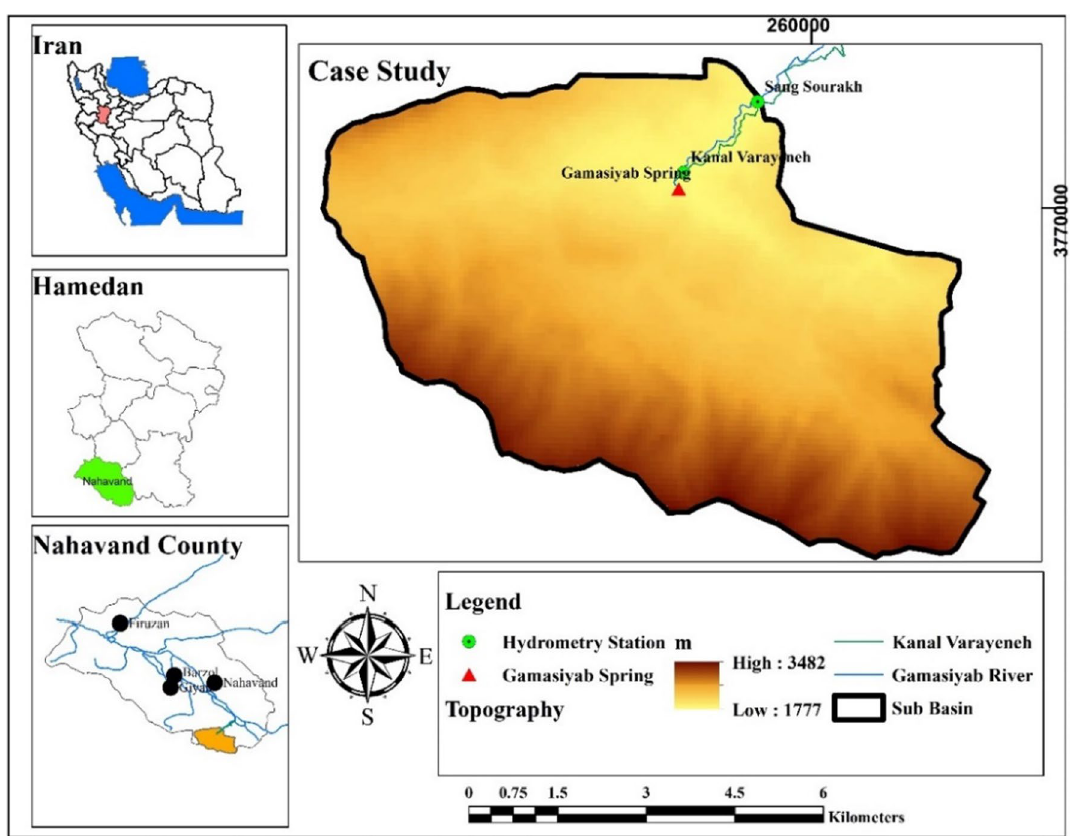
Fig. 1 Location of the Gamasiyab spring in Iran